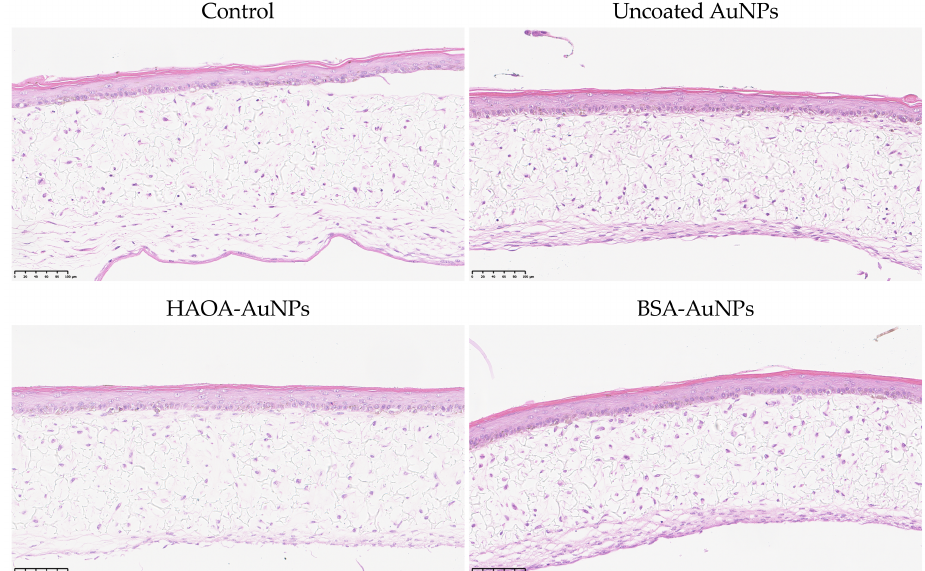
Figure 5. Histopathological images (H&E staining) of three-dimensional reconstructed human skin model cross-sections 24 h after incubation with uncoated AuNPs, HAOA-AuNPs and BSA-AuNPs at a concentration of 200 µM. Scale bars: 100 µm.